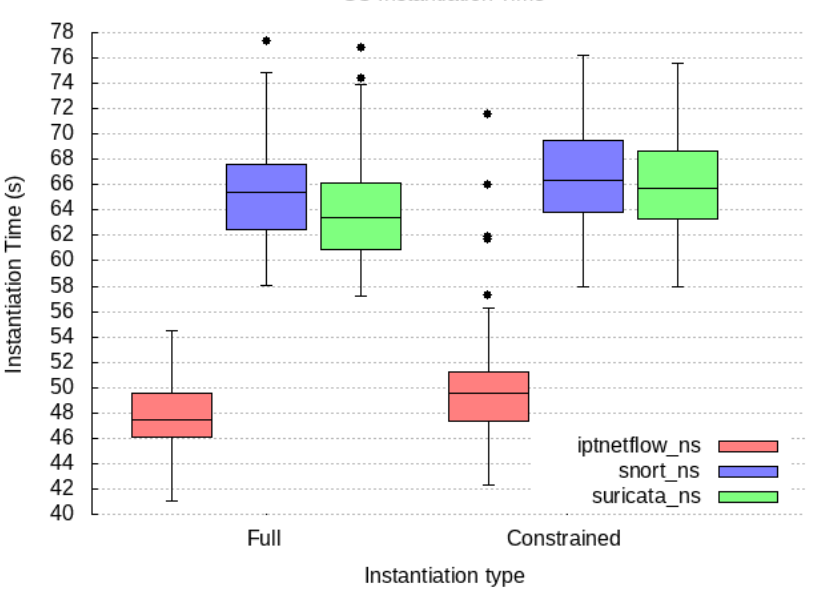
Figure 11. Distribution of instantiation times for the three devised SCs, comparing full ( left ) and constrained ( right )